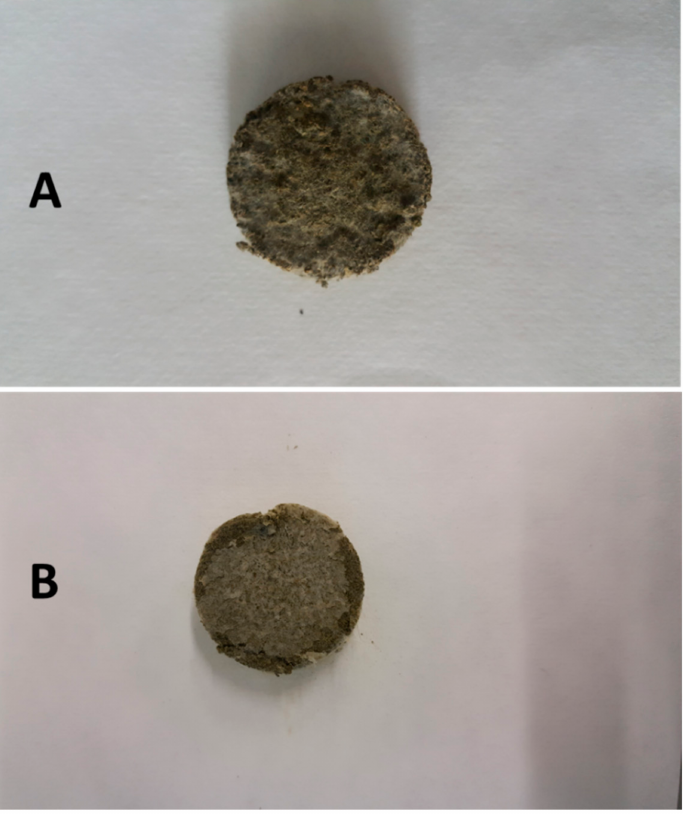
Figure 1. A. oryzae 5 days inoculated with mycelium ( A ) and A. oryzae 8 days inoculated with spores ( B